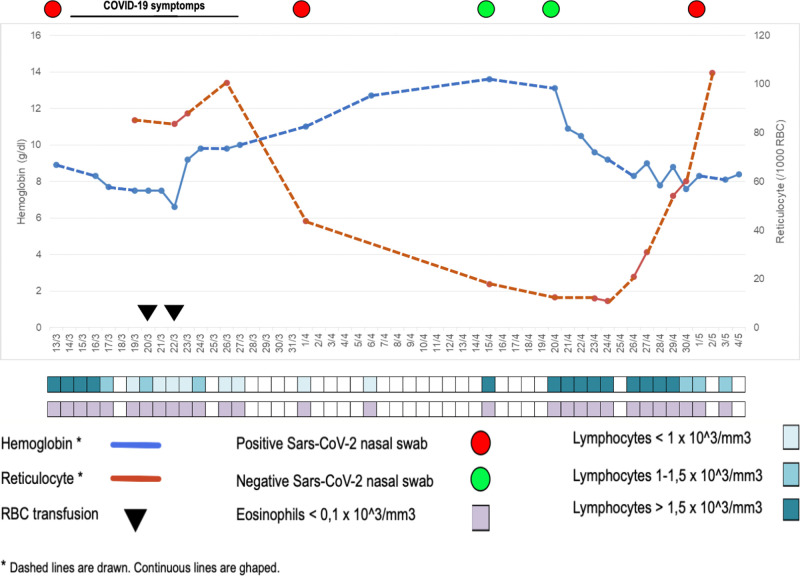
Hematologic, clinical, and virological data of patient #1, indicating the concomitant occurrence of hemolysis and virus SARS-CoV-2 detection in nasal swab.